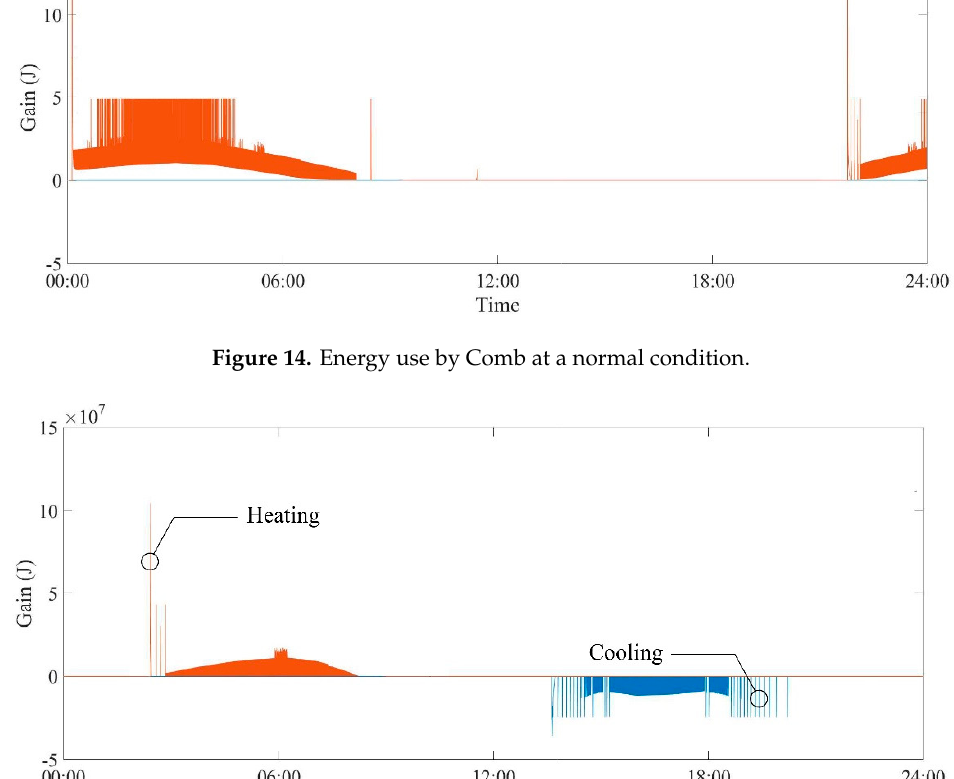
Table 2. Comparison of control